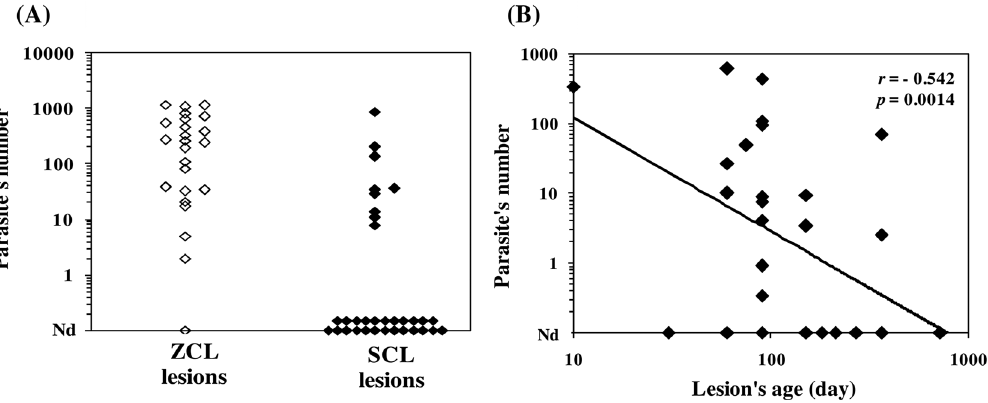
Figure 2. Parasite load within ZCL and SCL lesions. (A) Results were expressed as parasite number per 10 5 human cells. (B) Expression of the number of parasites according to the age of the lesion. Correlation between lesion age and parasite number was evaluated using the Spearman ’ s rank correlation test, r: correlation coef fi cient; p < 0.05 was considered statistically signi fi cant. Nd; not